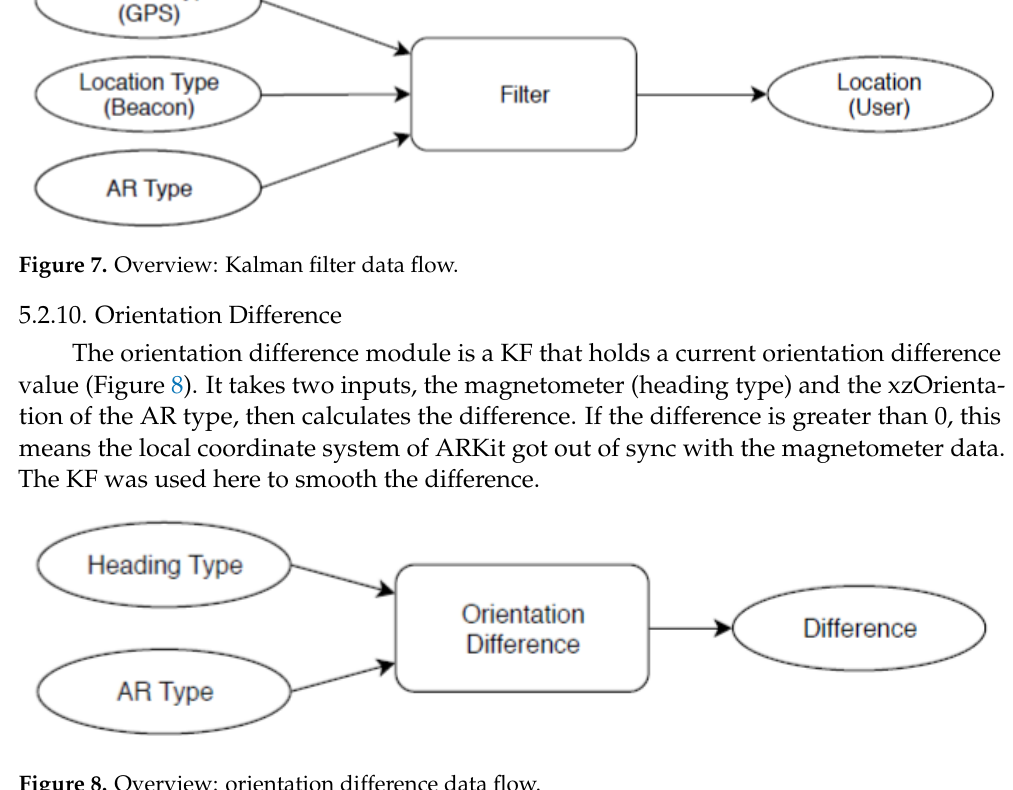
Figure 8. Overview: orientation difference data